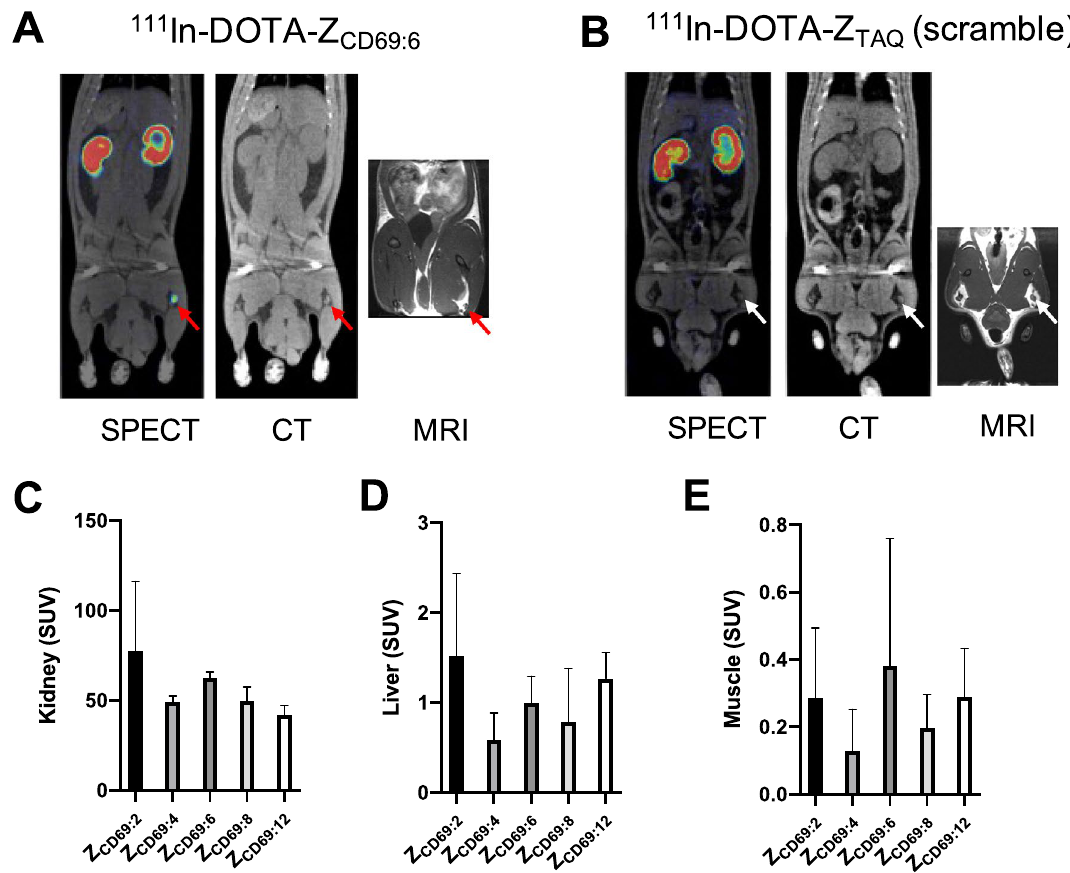
Figure 5. Representative coronal SPECT, CT and MRI images showing biodistribution and lymph node (red arrows) uptake 24 h post administration of 111 In-DOTA- Z CD69:6 ( A ) and negative control 111 In-DOTA- Z TAQ ( B ). Bar diagrams showing uptake in kidney (48 h post administration, C ), liver (3 h post administration, D ) and muscle (3 h post administration, E ) of the five different indium-111 labeled CD69 targeting variants, measured from SPECT/CT images (n = 3 rats